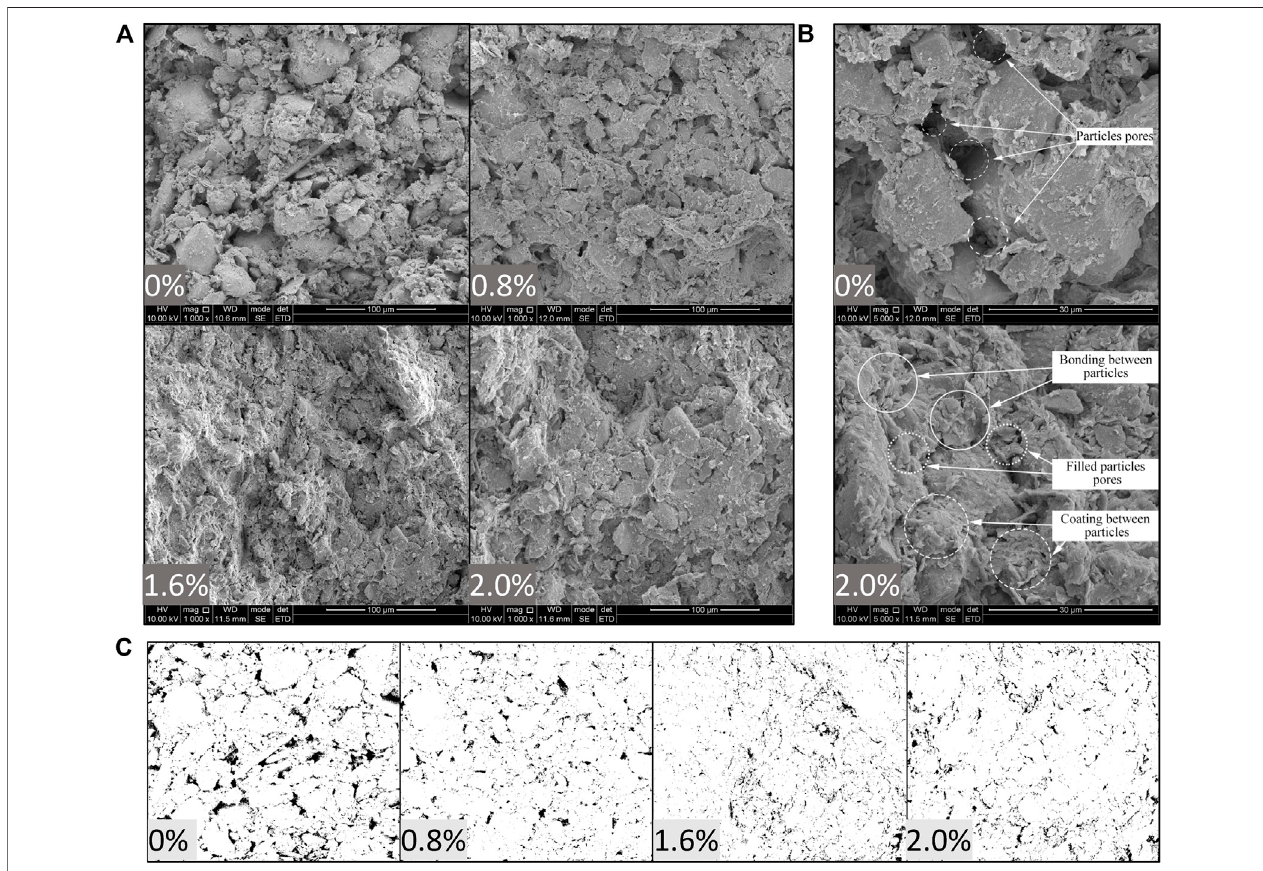
FIGURE 9 | Scanning electron micrographs of untreated and cross-linked polymer (CLP)-treated loess samples after 28 days curing at 1,000 × magni fi cation: (A) untreatedloess; (B) 0.8%CLP-treatedloess; (C) 1.6%CLP-treatedloess;and (D) 2.0%CLP-treatedloess.And5,000 × magni fi cation: (E) untreatedloess;and (F) 2.0% CLP-treated loess after curing for 28